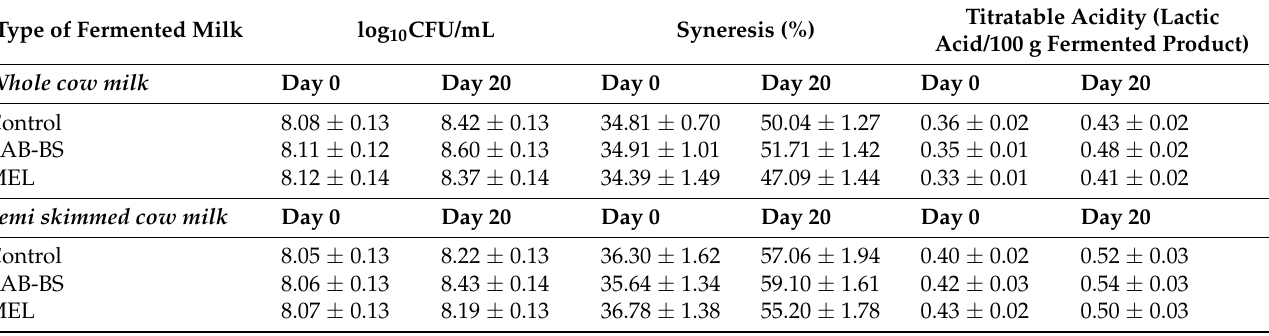
Table 2. Microbiological and physicochemical changes during cold storage of fermented milk pre- pared using the strain L. fermentum ACA-DC 0183 on whole and semi skimmed milk with and without the addition of lactobacilli and Moesziomyces